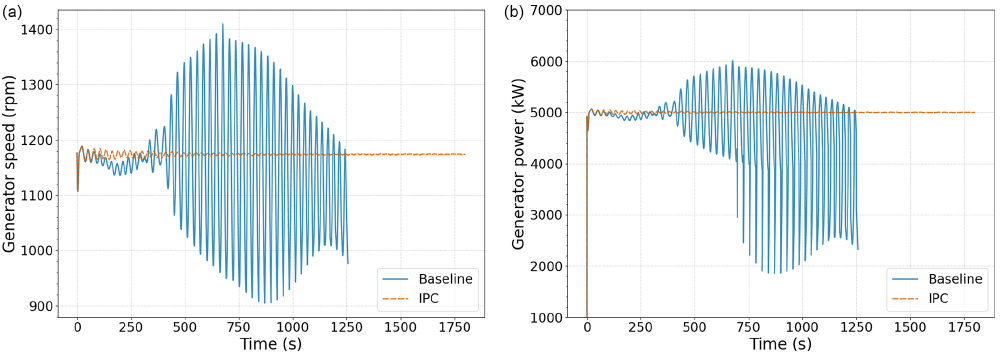
Figure 11. Generator speed (a) and generator power (b) with (dashed orange) and without yaw-by-IPC loop (solid blue) and an NWP wind speed of 20ms − 1 .